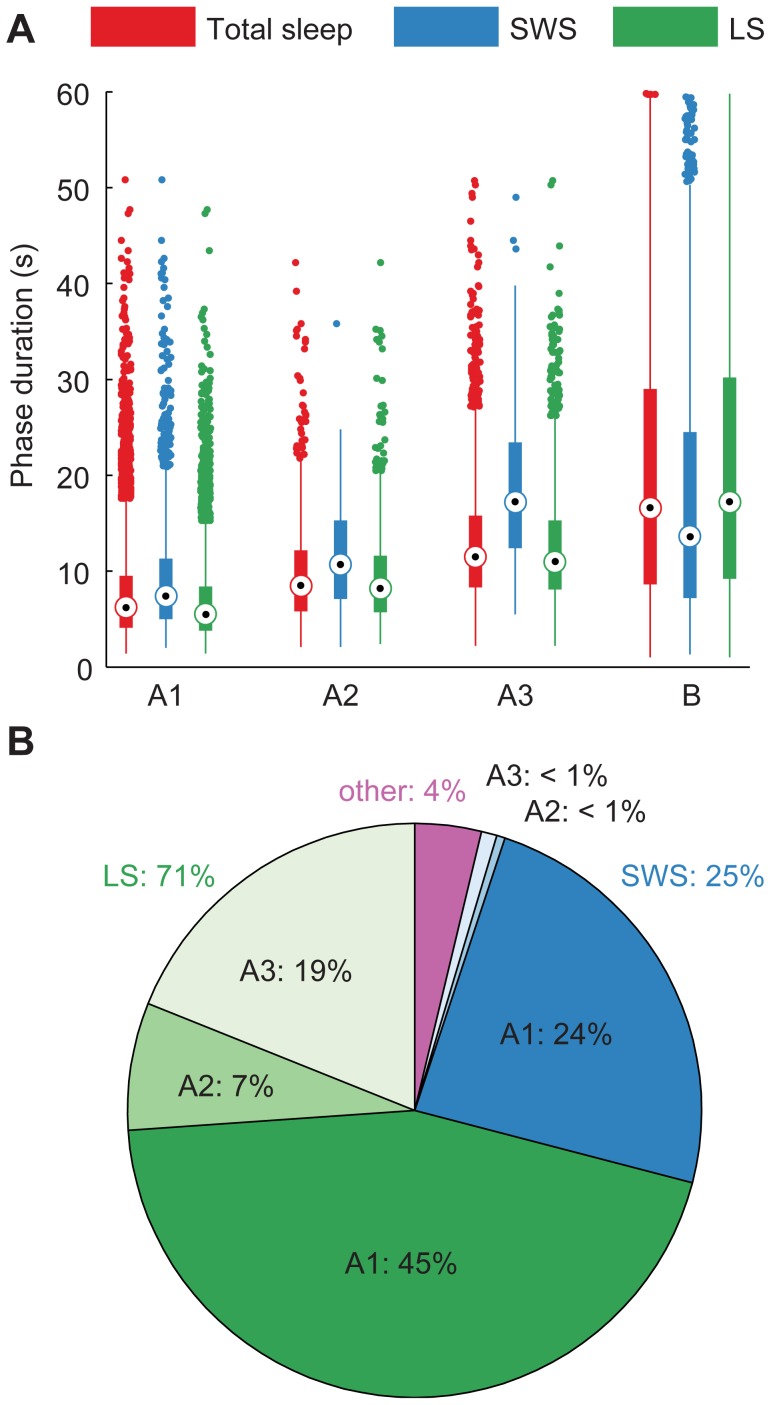
Descriptive statistics of CAP phases.(A) Distribution of phase durations and (B) division of phases into subtypes and sleep stages. Total sleep is marked red, SWS blue, LS green, and other times (movement time or changing sleep stage during the phase) purple. The box plots in (A) show the interquartile range as a box and the median as a circled dot inside the box. If the data includes outliers, i.e. dots outside of the whiskers, the whiskers are 1.5 times the interquartile range. Otherwise, they span the range from the minimum to the maximum value. A3 was on average the longest and A1 the shortest of phases A. Most of the CAP cycles were scored as A1+B and most of them occurred in LS.